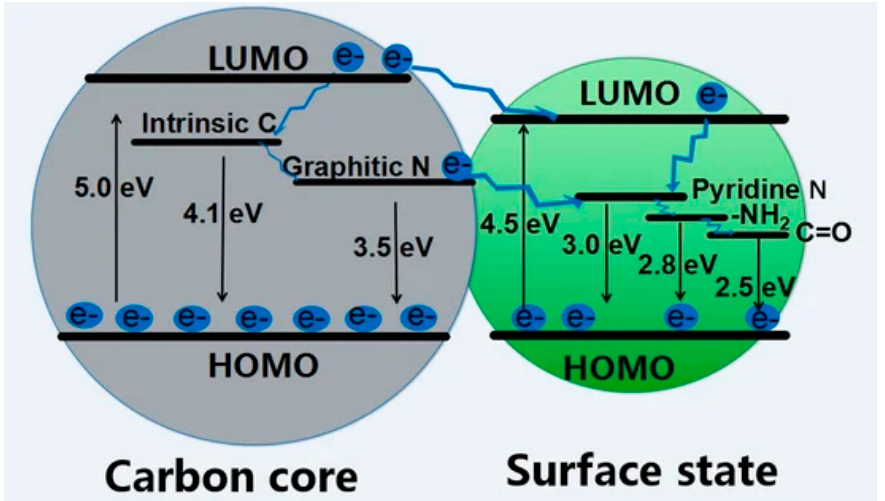
Figure 4. Scheme of the fluorescence emission of CQNDs based on different core/shell size ratios and surface residues. Reprinted with permission from Yu et al. [66] under CC BY 4.0.